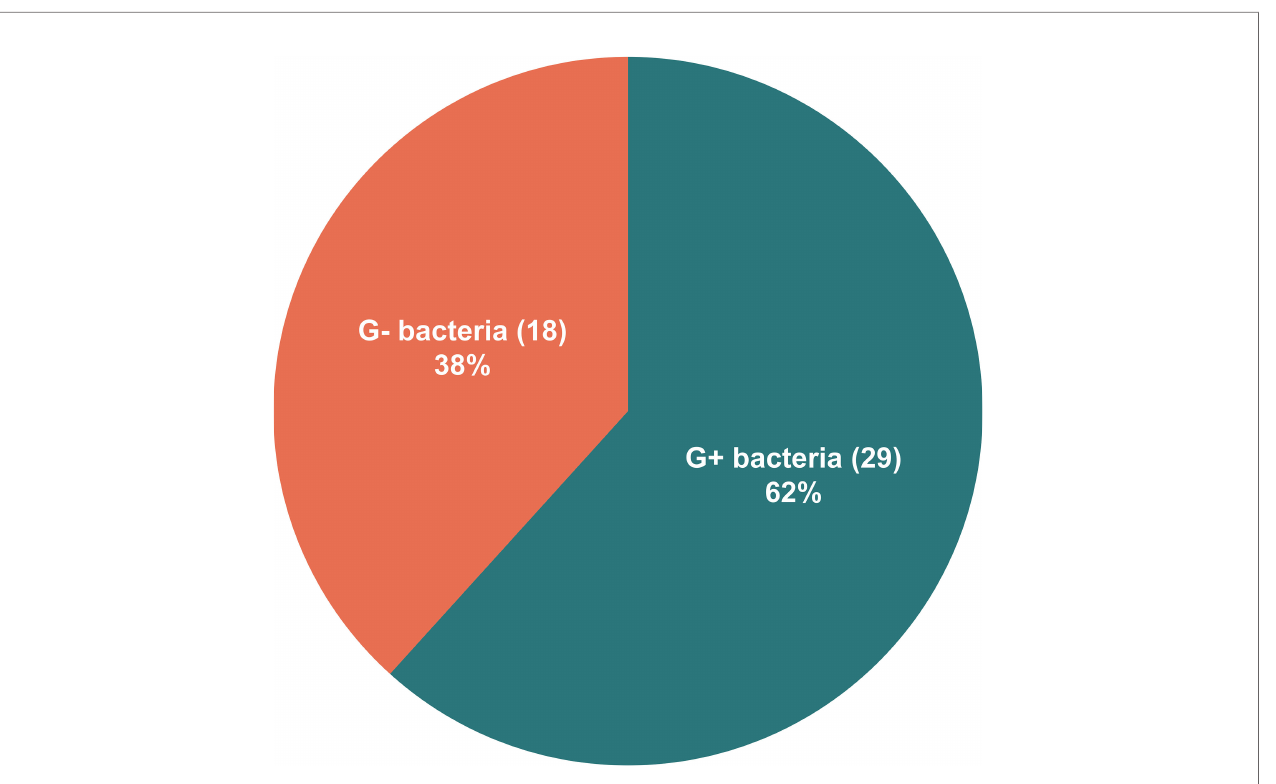
Frontiers in Cellular and Infection Microbiology |